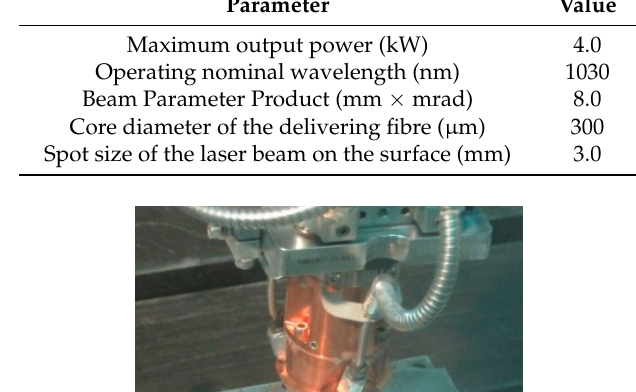
Figure 2. Laser head performing direct metal deposition.